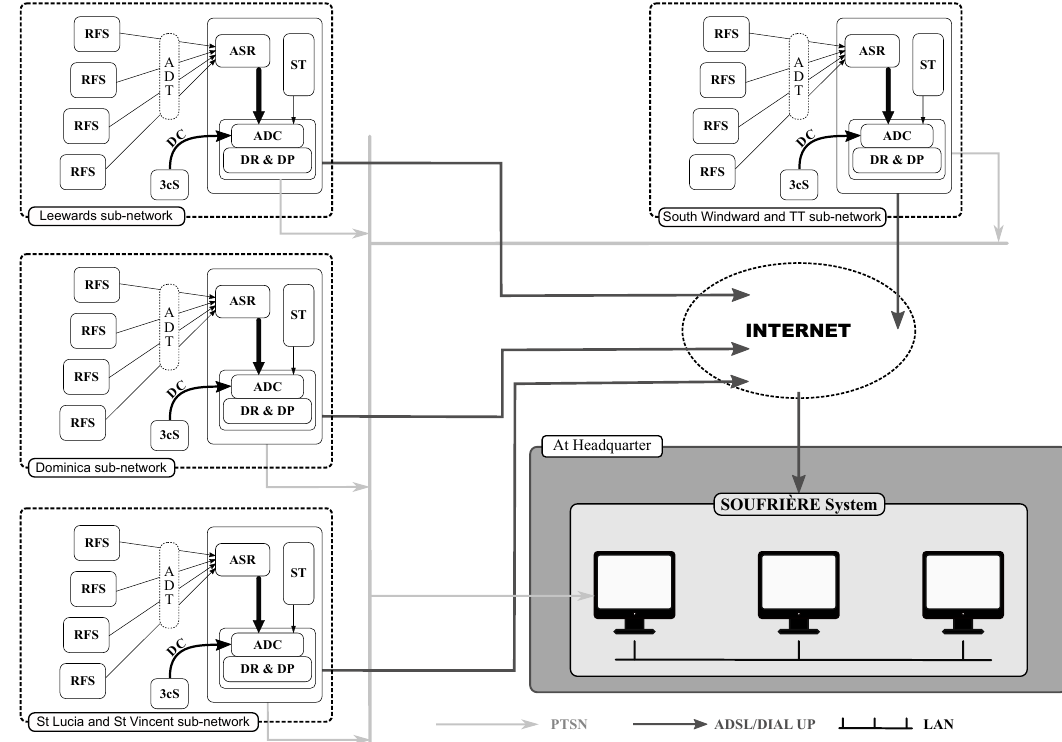
Figure 5. The 1998 SRU’s hybrid network including newly installed Class 4 stations. 3cS: Three-component seismometer; ADC: Analog to digital converter; ADT: Analog data transmission; ASR: Analog signal reception; DR & DP: Digital recording and digital processing; RFS: Remote field station; ST: Synchronized time; TT: Trinidad and Tobago. Figure adapted after Lynch pers.